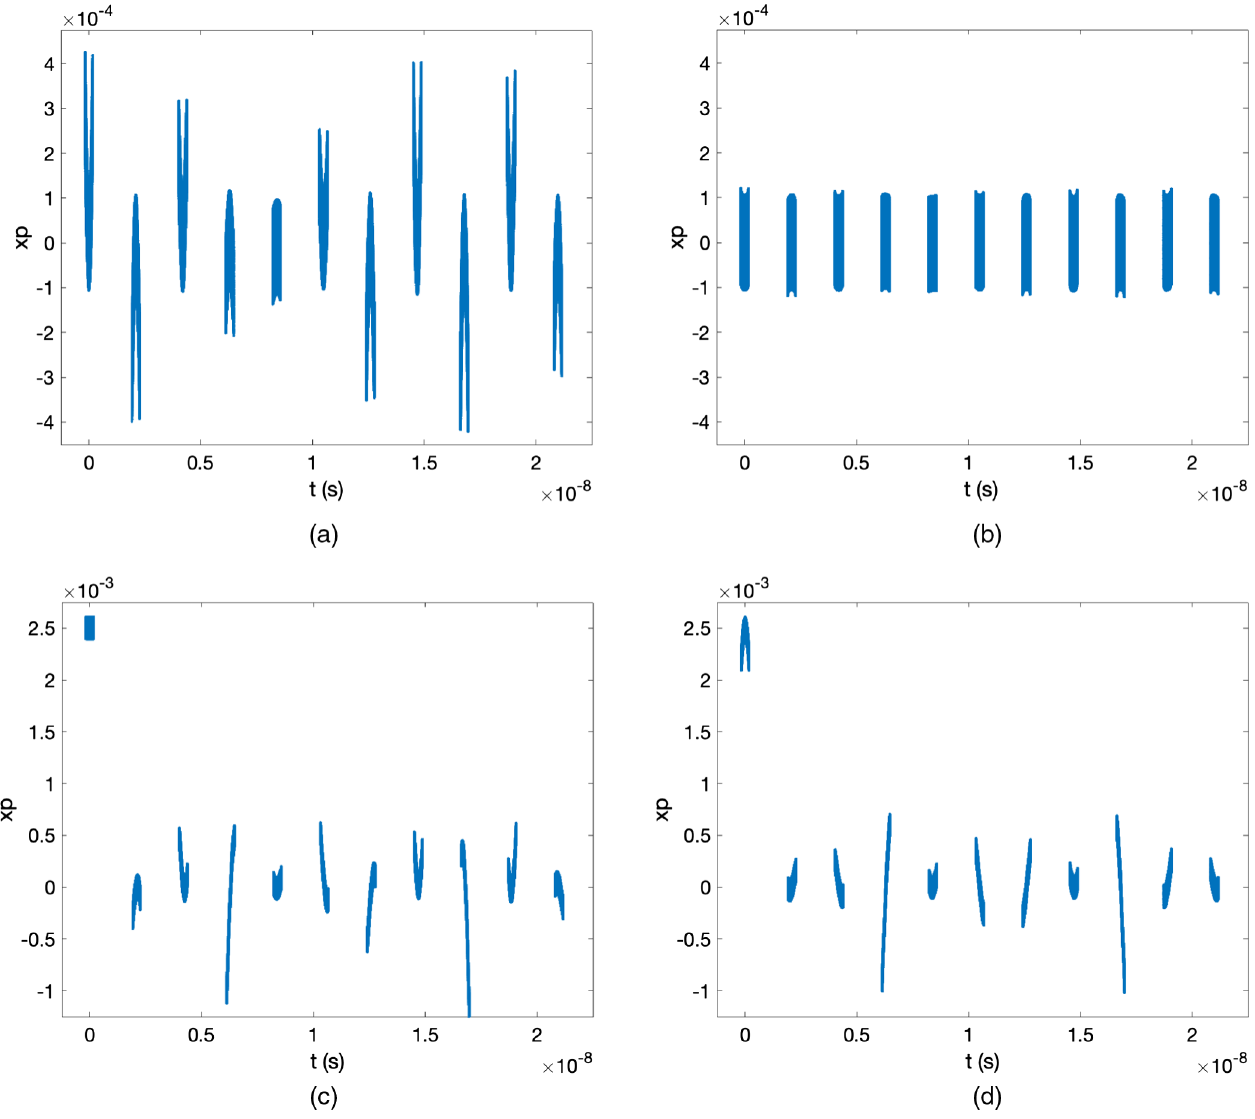
FIG. 5. Longitudinal profiles of an electron bunch circulating 11 turns: at the CCR (top) and on the recirculation transport before injection kick (bottom) with (left) and without (right) the use of a prekicker. (a) Longitudinal profile of the angular divergence, x circulating electron bunch at the cooler (without prekicker).(b) Same as in (a) but with prekicker. (c) Same as in (a) but just before the injection kicker. (d) Same as in (c) but with-prekicker. The curvature of the first bunch is due to the